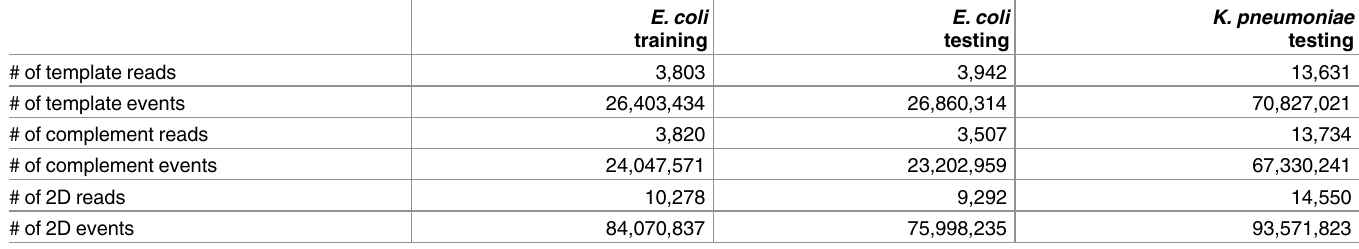
Table 2. Sizes of experimental data sets. The sizes differ betweenstrands becauseonly base calls mappingto the reference were used. Note that the counts of 2D events are based on the size of the alignment.